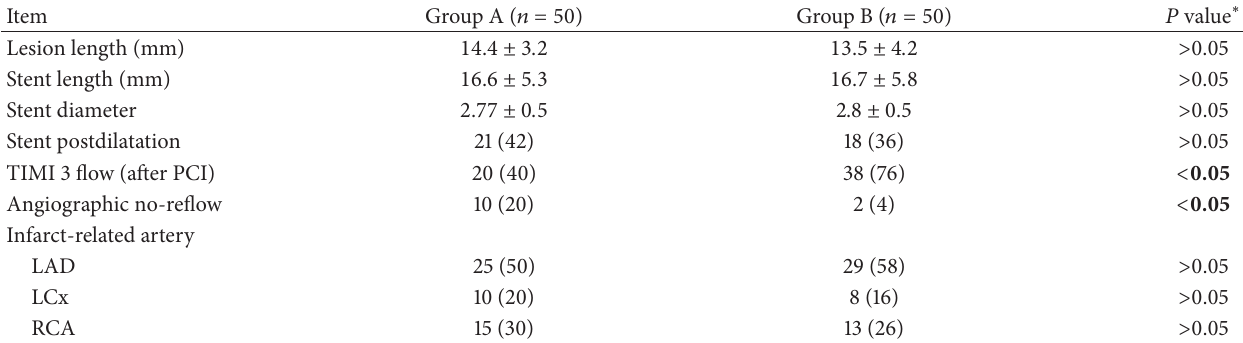
Table 2: Procedural characteristics of the two study groups.